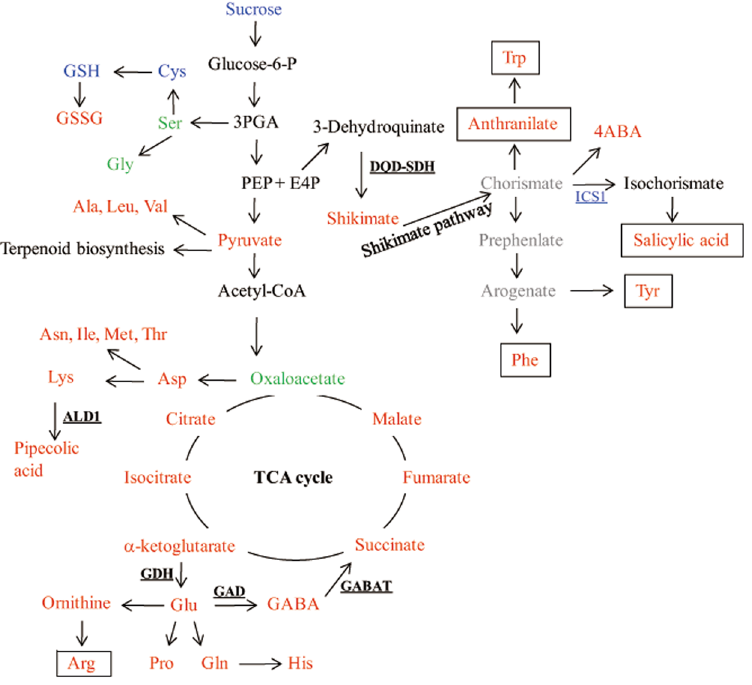
Figure 1. Schematic overview of the changes in the primary metabolic biosynthesis pathways compared between dsOW62/76 and ZH17 plants. The compound in red, blue, and green indicated that its accumulation was increased, decreased, and not changed significantly in dsOW62/76 in related to ZH17 plants. The compound undetectable was in gray. Genes or enzymes were shown as underlined. The genes analyzed by qPCR were in red or blue, representing increase or decrease their transcription levels in dsOW62/76. Some of the genes upregulated in the transcriptome analysis were shown in bold. The compounds boxed are precursors may be mentioned in the later studies. Abbreviations: 4ABA, 4-aminobenzoic acid; E4P, erythrose 4-phosphate; GABA, γ -aminobutyric acid; GSH, glutathione; GSSG, glutathione oxidized; PEP, phospho enol pyruvate; 3PGA, 3-phosphoglycerate; ALD1, aminotransferase 1; DQD-SDH, 3-dehydroquinate dehydratase-shikimate dehydrogenase; GABAT, 4-aminobutyrate-pyruvate transaminase; GAD, Glu decarboxylase; GAH, Glu dehydrogenase; ICS, isochorismate